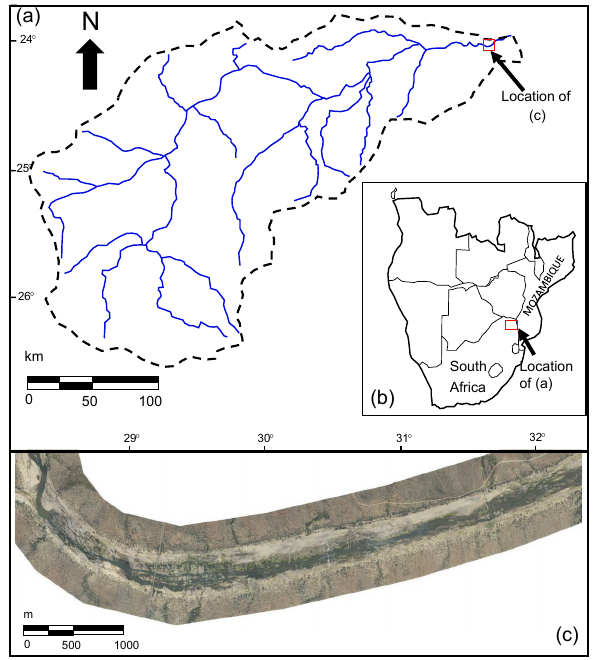
Figure 1. Olifants River catchment; (a) catchment map, (b) loca- tion in South Africa, (c) aerial photograph (May 2012) of reach in the Kruger National Park used for